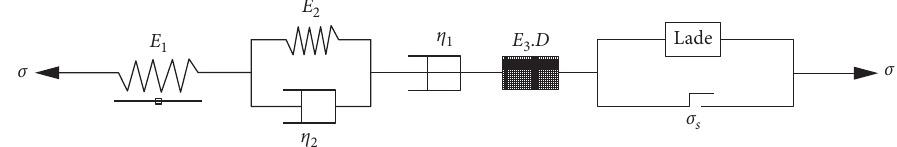
Figure 9: Damage creep model of fractured rock